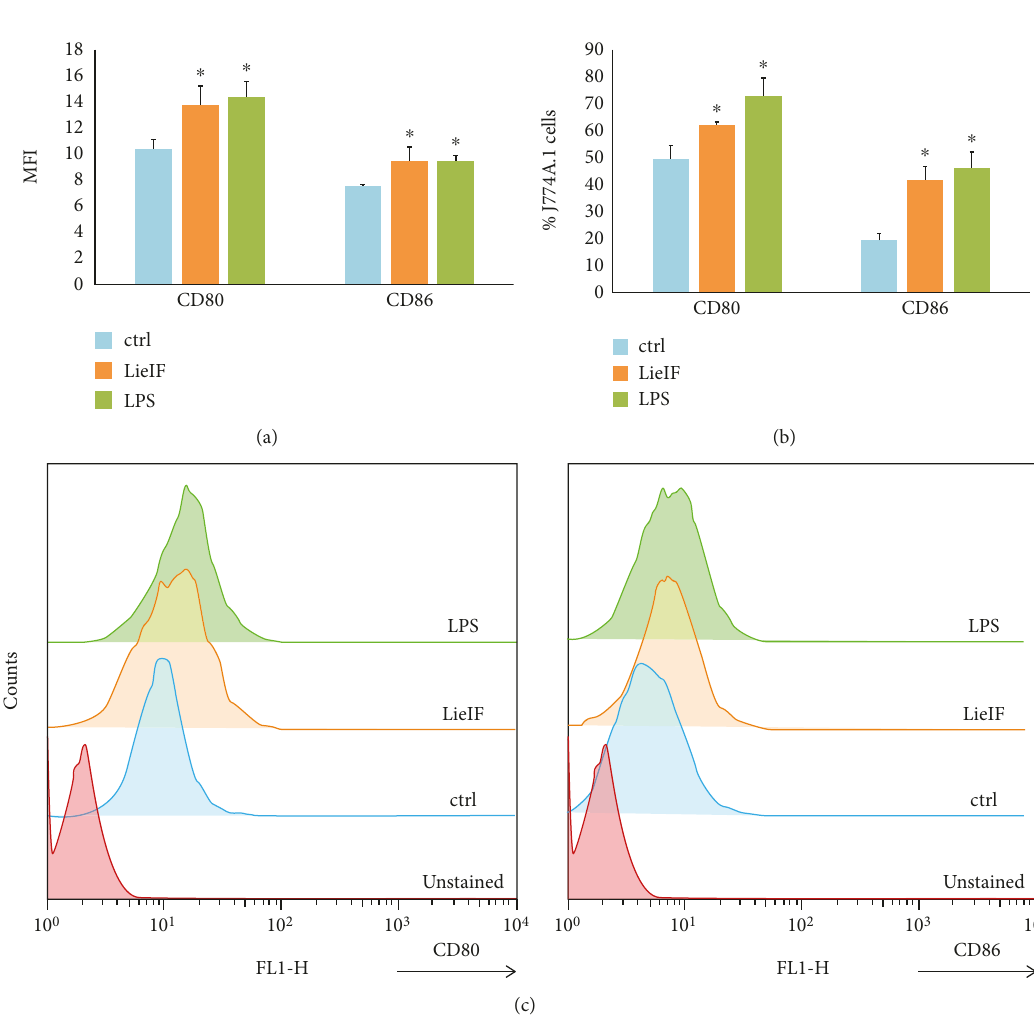
Figure 4: E ff ect of recombinant LieIF protein on the expression of co-stimulatory molecules by J774A.1 macrophages. Macrophages were stimulated with recombinant LieIF (10 μ g/mL) for 24 h, and the expression of CD80 and CD86 molecules was measured using FACS with the use of speci fi c monoclonal fl uorochrome-labeled antibodies. Macrophages stimulated with LPS (1 μ g/mL) were used as the positive control while unstimulated cells were used as the negative control. The results are expressed as (a) median fl uorescent intensity (MFI) and (b) percentage (%) of macrophages expressing CD80 and CD86 molecules. Data are presented as mean values ± SD of three independent experiments. (c) Histogram overlays are representative of one experiment. ∗ indicates statistically signi fi cant di ff erences as compared to the negative